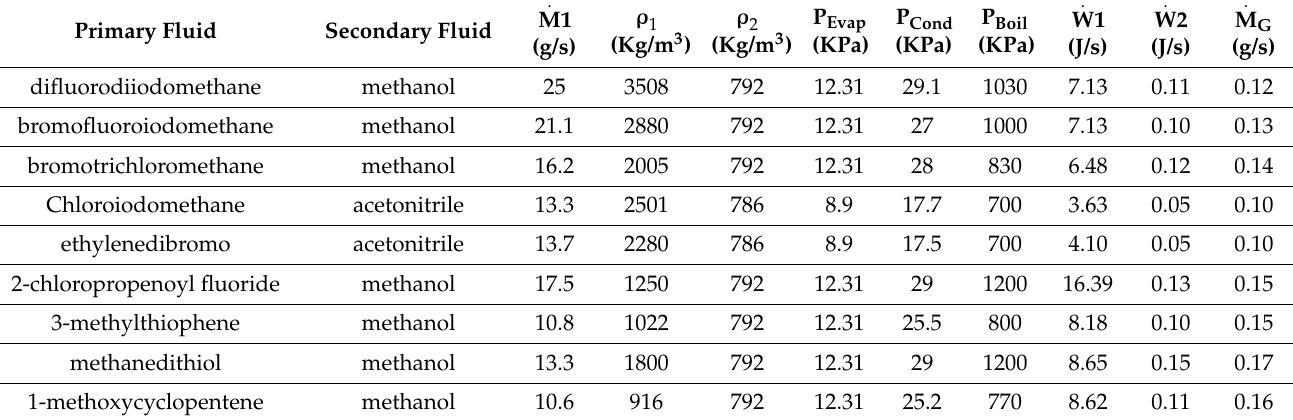
Table 1. Boiler feed pump and expansion valve power estimation for different binary fluid candidates. Primary